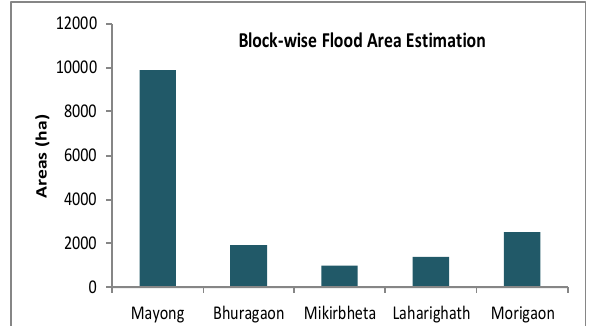
Figure 7. Block-wise Flood area